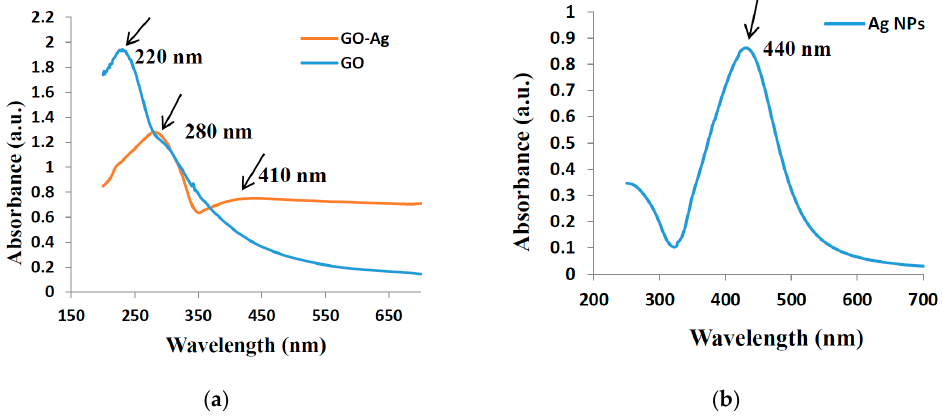
Figure 4. UV–visible of ( a ) GO and GO-Ag nanocomposites ( b ) Ag NPs.